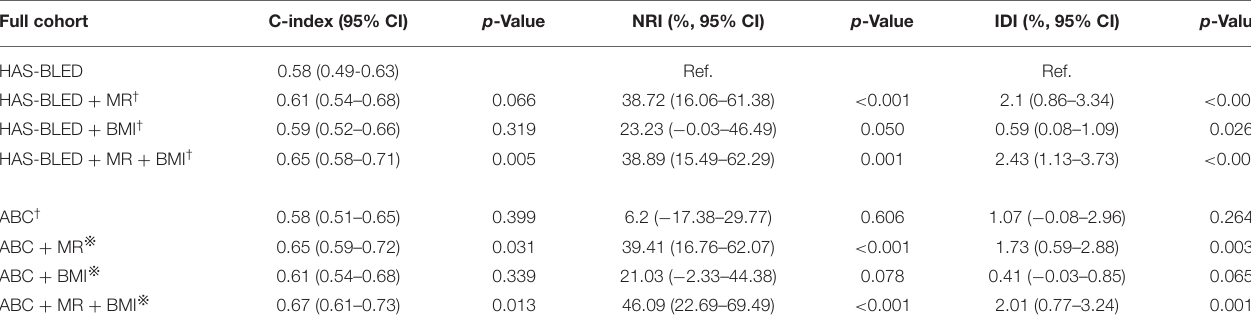
TABLE 4 | C-indices, ROC curves comparison, IDI, and NRI of the HAS-BLED score and ABC-bleeding score with or without mitral regurgitation or BMI to predict perioperative bleeding in the full